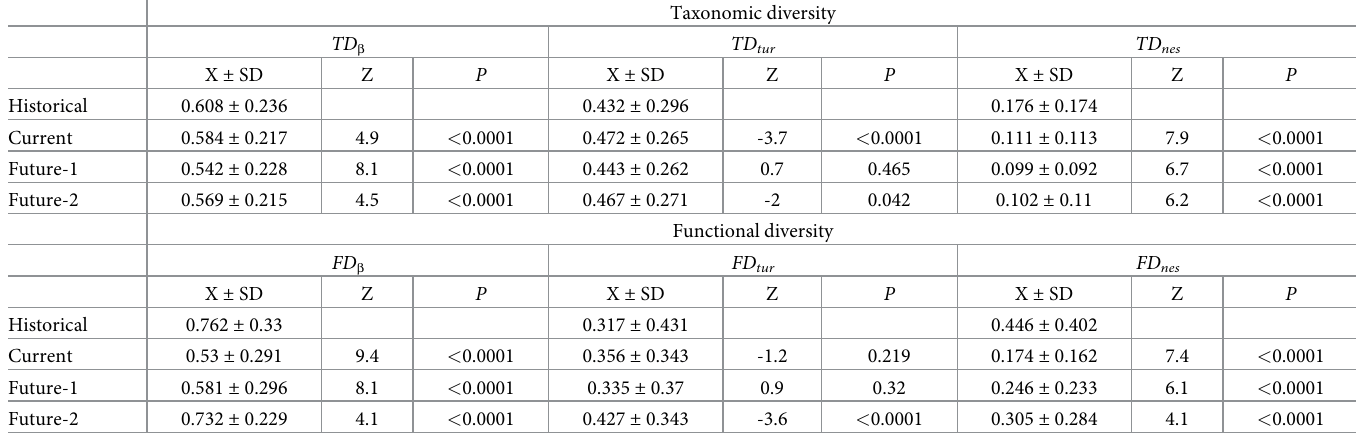
Table 1. β -diversity distribution (X ± SD), considering its taxonomic ( β -diversity, TD β ; turnover, TD FD β ; turnover, FD tur ; nestedness, FD nes ) in 20 freshwater fish assemblages of continental Chile. The values were calculated for the Historical and Current composi- tional scenarios, as well as for two hypothetical scenarios (Future-1 and Future-2) that assume intensification of the extinction of native species. The statistical comparisons refer to contrasting all scenarios against the historical scenario (Wilcoxon’s signed-rank